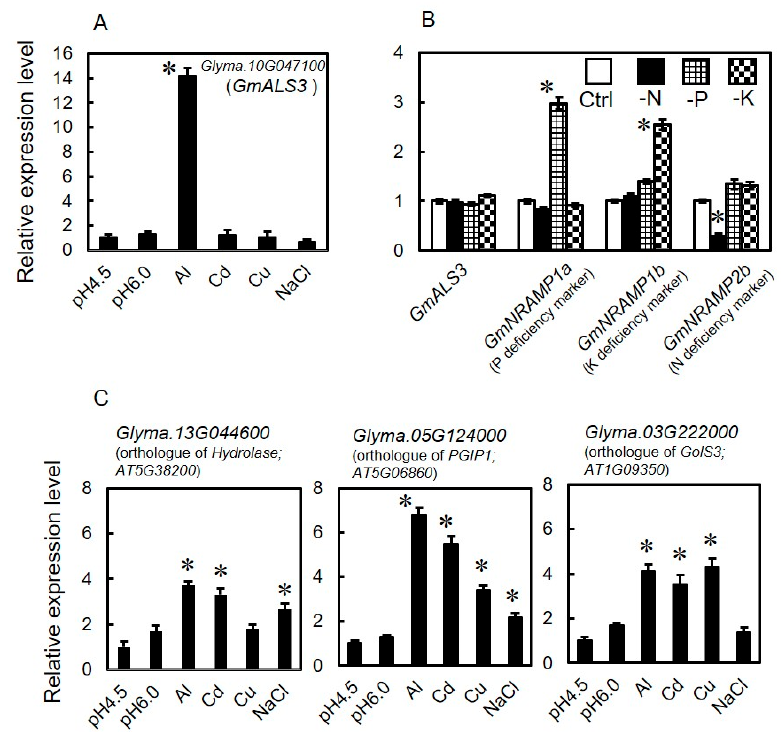
Figure 2. Specificity of the GmALS3 ( Glyma.10G047100 ) in response to Al rhizotoxicity in soybeans. ( A ) Expression of GmALS3 in the shoots of 10-day-old pregrown soybean plants after exposure of the roots to without rhizotoxic ions (0 µM Al, Cd, Cu or NaCl; pH 4.5 or 6.0) or with various rhizotoxic (50 µM AlCl 3, 25 µM CdCl 2 , 10 µM CuSO 4 and 75 mM NaCl; pH 4.5; concentrations used in the root growth inhibition study; Figure S2A) solutions for 24h; ( B ) GmALS3 expression along with nutrient-responsive marker genes ( GmNRAMP1a, GmNRAMP1b and GmNRAMP2b ) in the shoots of 10-day-old pregrown soybean plants after exposure of the roots to nutrient solution with deficiencies in nitrate (-N), potassium (-K) or phosphate (-P) for 24 h (pH 6.0); ( C ) expression of other genes [orthologs of specifically Al-inducible genes in Arabidopsis; Glyma.13G044600 (orthologue of Hydrolase; AT5G38200 ) , Glyma.05G124000 (orthologue of PGIP1; AT5G06860 ) , Glyma.03G222000 (orthologue of GolS3; AT1G09350 )] in the shoots of 10-day-old pregrown soybean plants after exposure of the roots to without rhizotoxic ions (0 µM Al, Cd, Cu and NaCl; pH 4.5 or 6.0) or with various rhizotoxic (50-µM AlCl 3, 25-µM CdCl 2 , 10-µM CuSO 4 and 75 mM; pH 4.5) solutions for 24 h. Expression levels quantified using qRT-PCR. UBQ10 was used as an internal standard. Data are presented as the means ± SE ( n = 3).Asterisks indicate a significant difference (Student’s t- test, p < 0.05) from without rhizotoxic ions (pH 4.5) in panels ( A ) and ( C ) and control nutrient solution in panel ( B ).